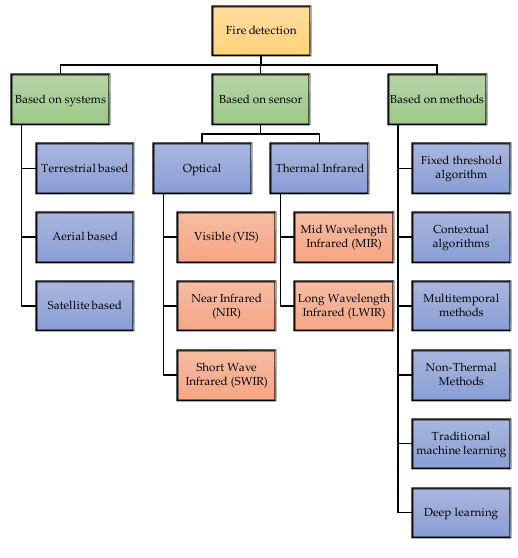
Figure 1. Fire detection methods.